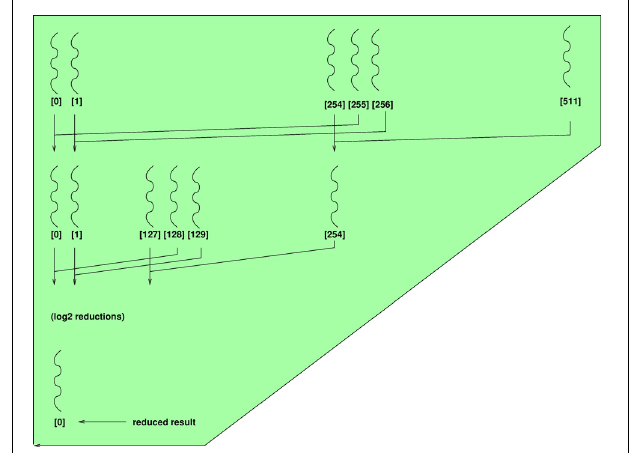
FIGURE A1 | Parallel reduction for computing summary